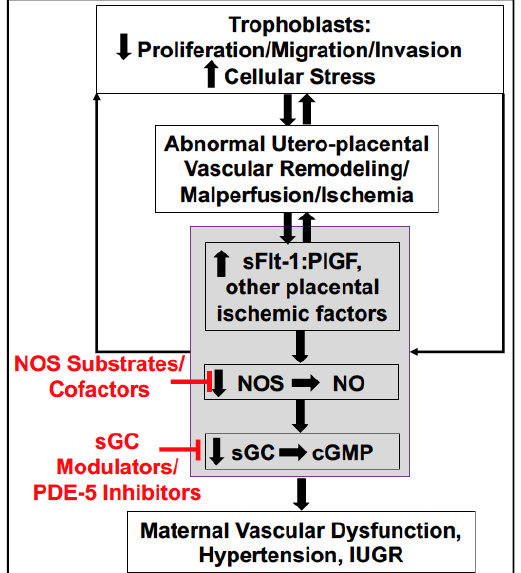
Figure 1. Schematic representation of the cascade of events leading from trophoblast dysfunction and cellular stress to subsequent abnormalities in uteroplacental vascular remodeling, malperfusion, and ischemia. These ischemia/hypoxic events elicit the release of anti-angiogenic and pro-hypertensive factors, like soluble Fms-like tyrosine kinase (sFlt-1), into the maternal circulation. This factor can feedback to reduce cellularity of the placenta, and reduce uteroplacental vascularity [24].